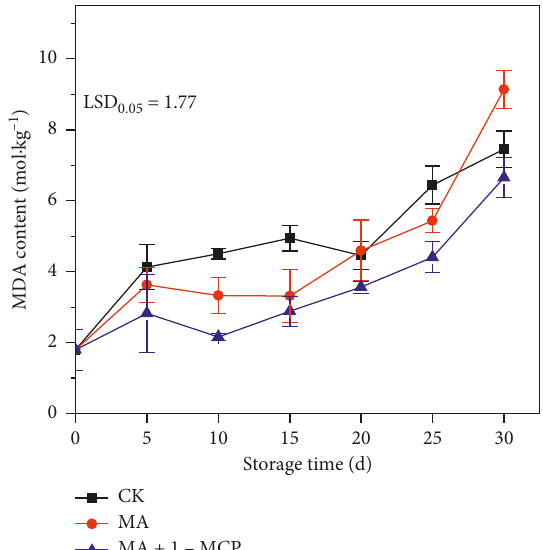
Figure 5: Effects of MA+1-MCP and MA treatment on the levels of MDA in fig fruit stored at − 1 ° C for 30 days. Data represent the mean value of five measurements ± the standard errors. LSDs represent significant differences at the 0.05